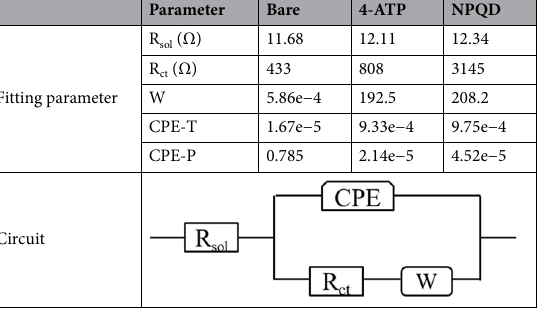
Table 1. Electrical circuit simulation by a Nyquist plot. R ct : charge transfer resistance, R sol : solution (bulk) resistance, W: Warburg coefficient, CPE-P: capacitance phase element P value, CPE-T: constant phase element T value.